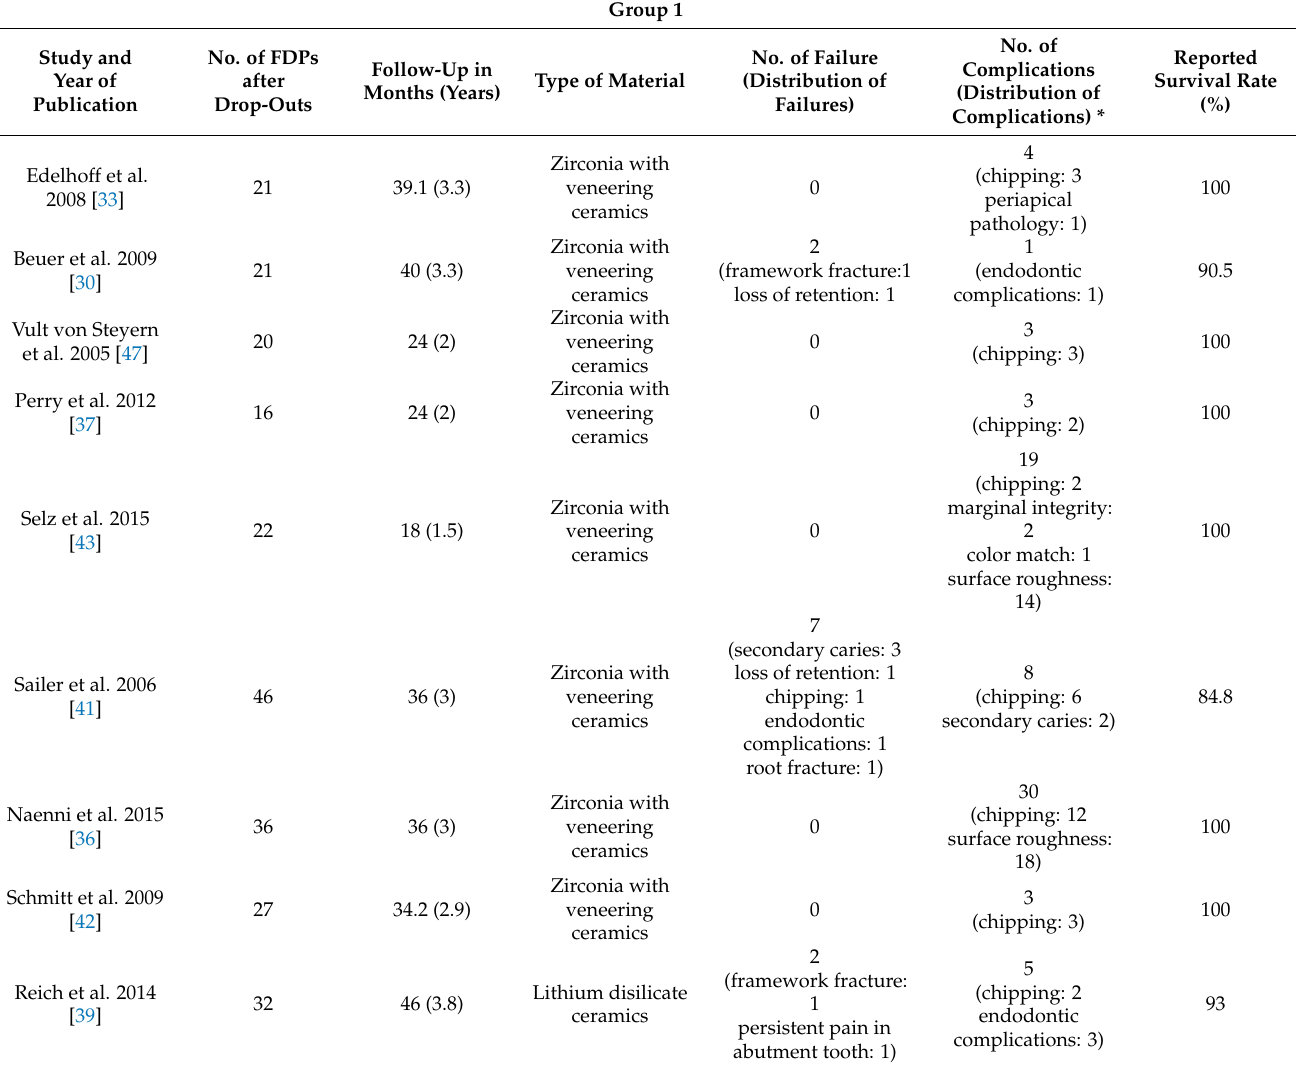
Table 2. Survival characteristics of studies stratified by follow-up time